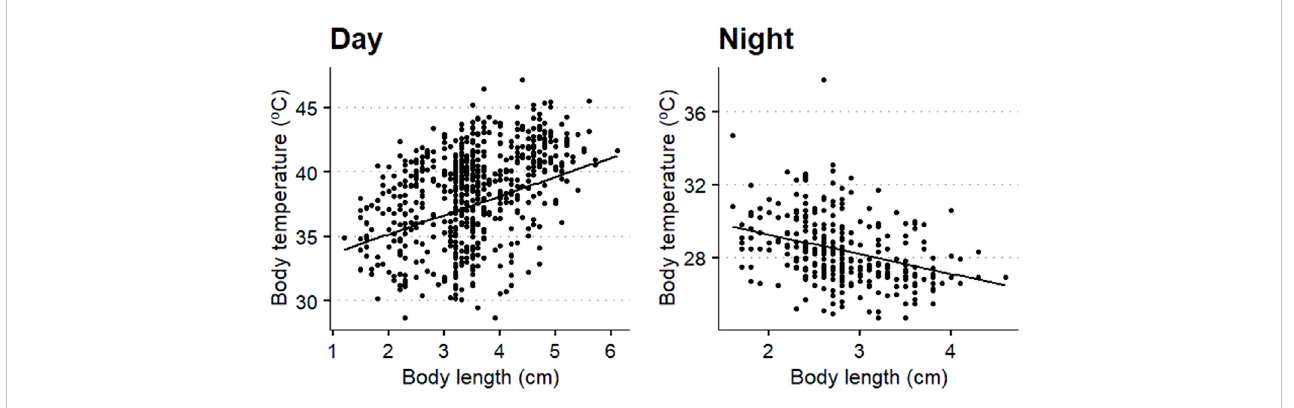
FIGURE 8 Scatterplots oftherelationbetweenbodytemperature of Locustamigratoriamanilensis and body length atday(left plot) andnight (right plot). Blackline shows the fi tted linear mixed model for the Dongying region and average ground